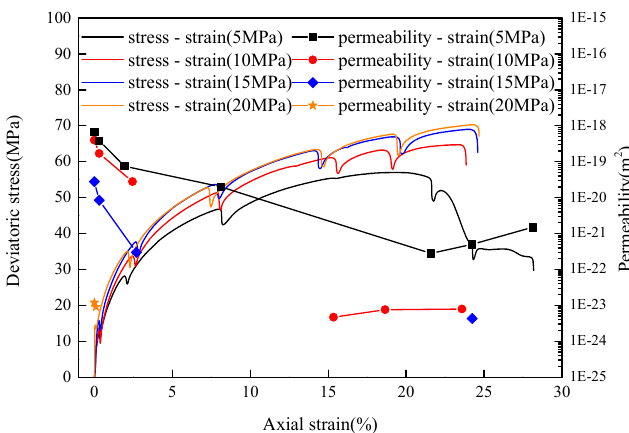
Figure 12. Permeability evolution of the pure salt rock under a different confining pressure.